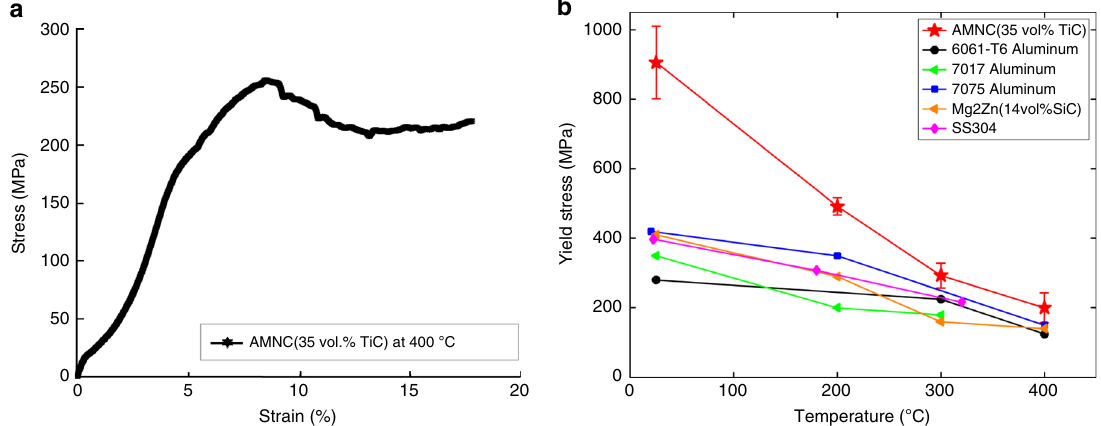
Fig. 4 Mechanical behavior of laser-deposited AMNC at elevated temperature. a Typical engineering stress – strain curves for microcompression of laser- deposited AMNC (35 vol.% TiC) at 400°C. b Yield strength of AMNC (35 vol.% TiC) at test temperatures of 25, 200, and 400°C in comparison with other materials. Error bars show s.d. of three tested